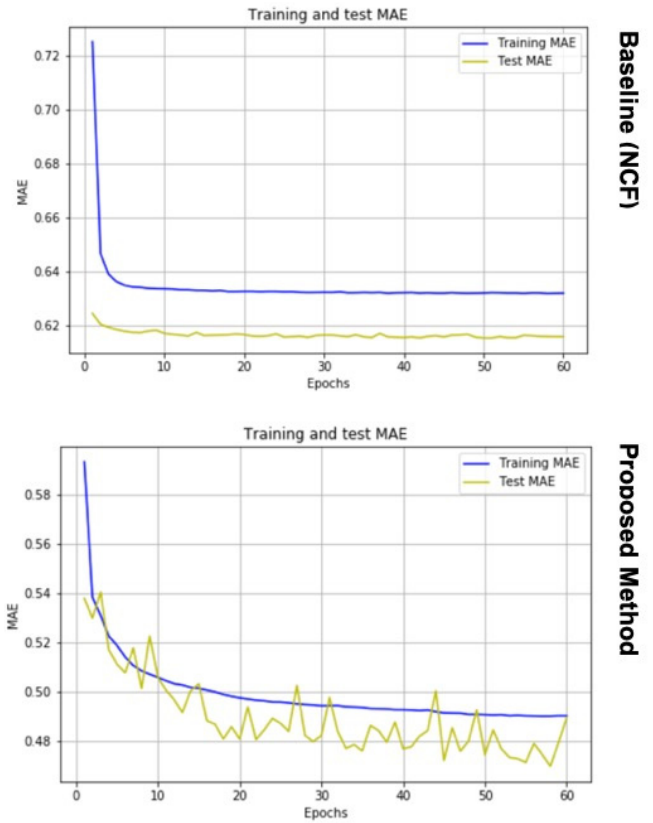
Figure 6. Netflix. Mean Absolute Error (MAE) obtained by training both the NCF baseline (top chart) and the proposed RNCF neural architecture (chart below). Training and testing evolutions for the 60 first epochs ( x